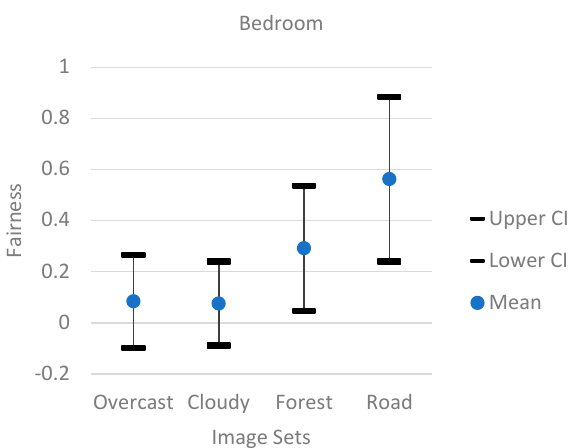
Figure 9. The 95% confidence interval graph for the bedroom model.